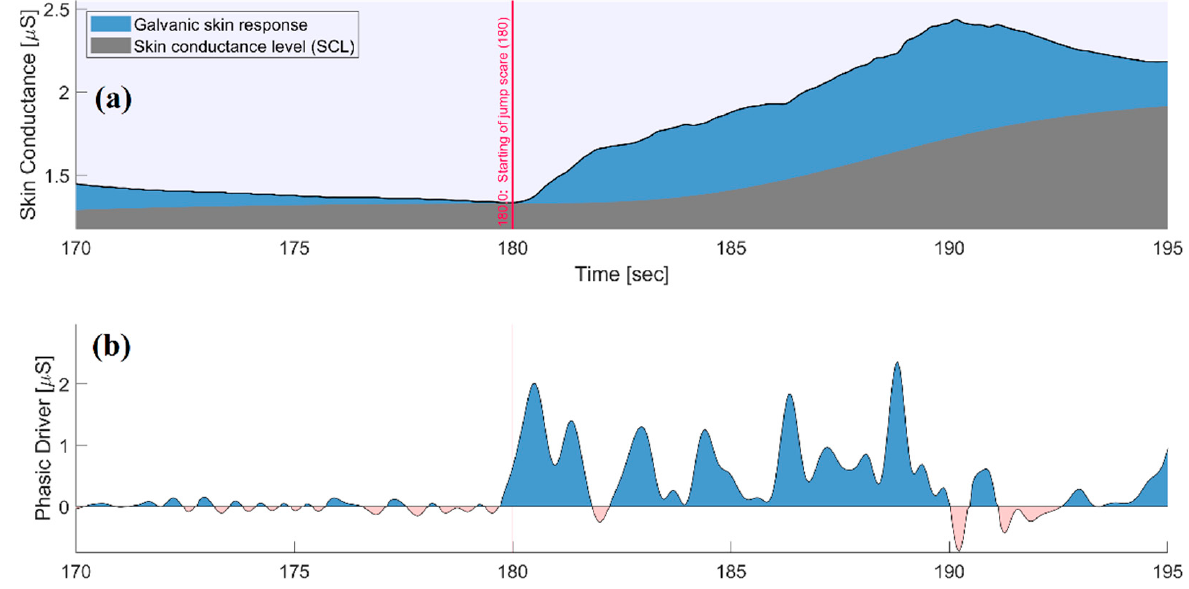
Figure 6. 25-s window of the GSR signal acquired during the experimental protocol and extraction of its components through LEDALAB toolbox. ( a ) GSR signal (blue area and black line) and SCL component (grey area); ( b ) SCR component in terms of phasic driver. The vertical red line denotes the transition between the R1 phase and the SF phase.